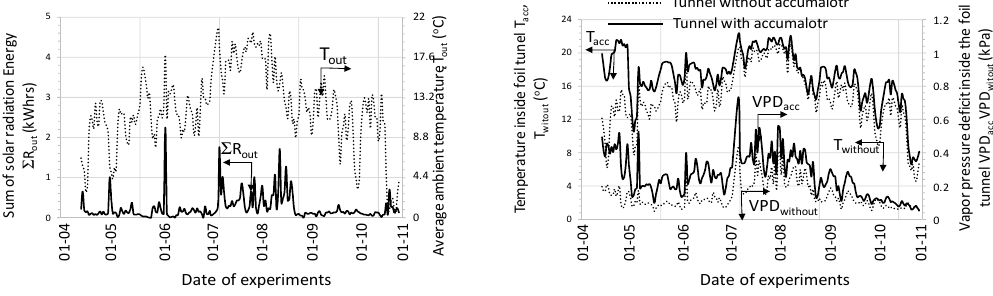
Figure 13. Averaged course of measured parameters during accumulator discharging cycles.